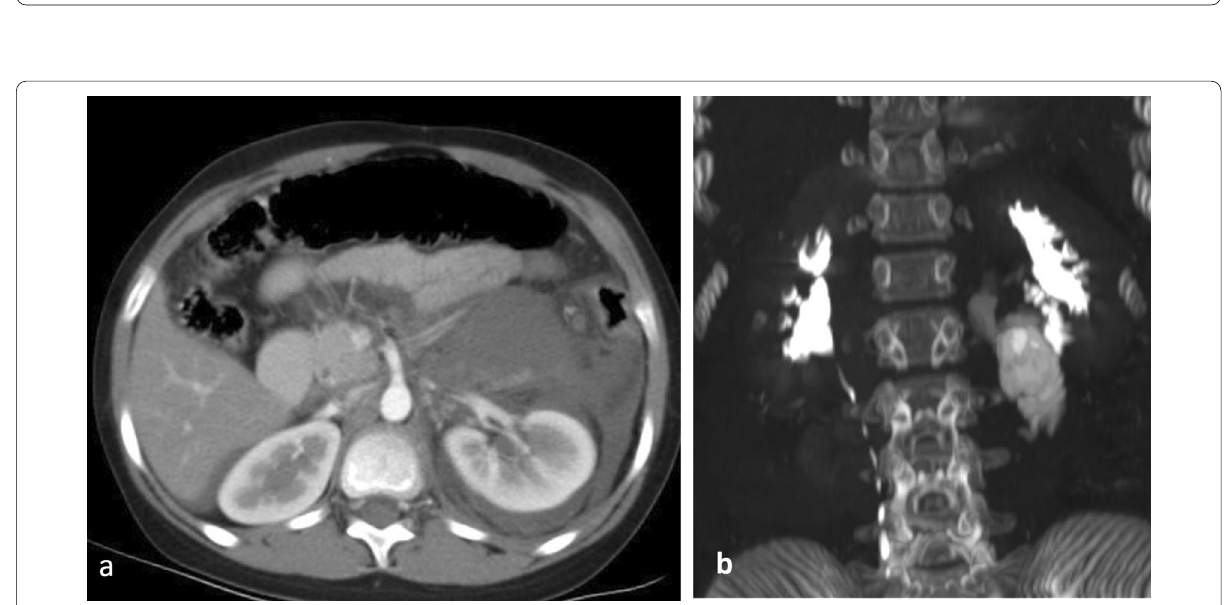
Fig. 16 12-year-old female with history of trauma. Ultrasound reveals perinephric collection (not shown). a Axial CT post-contrast at the nephrographic phase confirms the presence of perinephric collection. b Coronal MIP of the delayed excretory phase shows contrast extravasation from the injured pelvi-urerteric